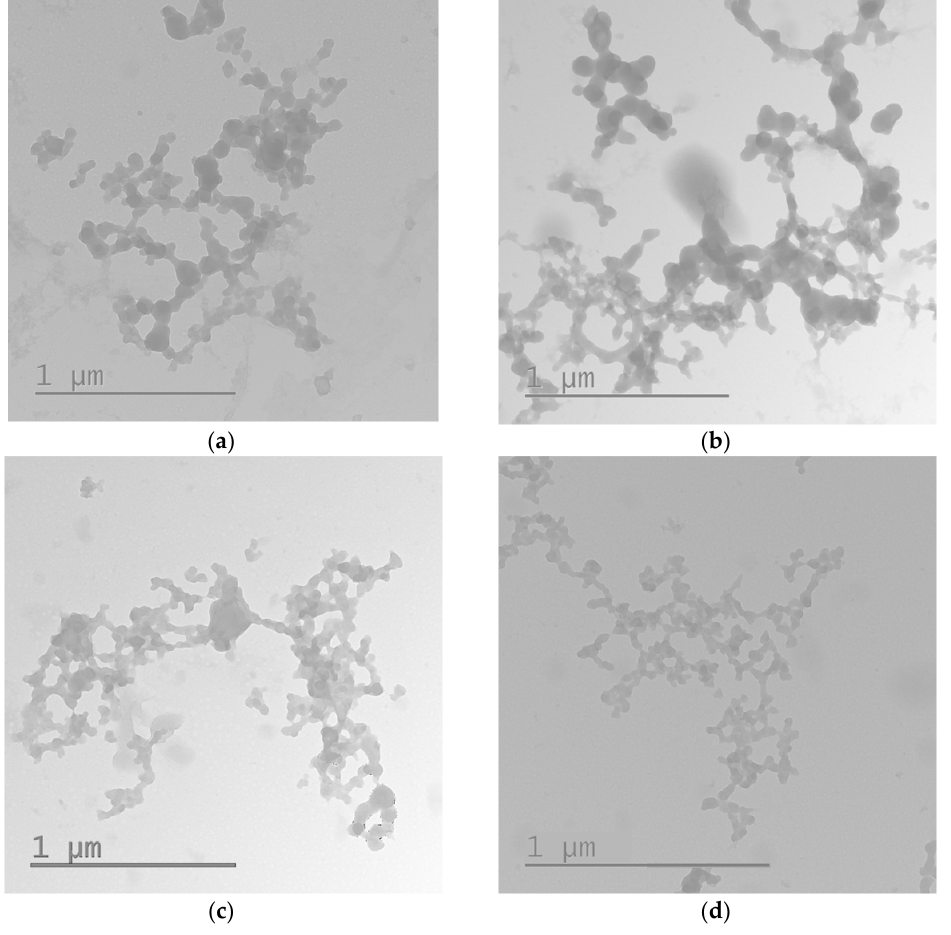
Figure 2. Typical micrographs of the RGD-R6p-0,75/DNA ( a , b ) and RGD0-R6p-0,75/DNA ( c , d ) polyplexes obtained by transmission electron microscopy: ( a , c ) N/P ratio 8/1; ( b , d ) N/P ratio 12/1. Previous studies on arginine-rich peptide/DNA polyplexes demonstrated that 6000 nm aggregates possess more efficient transfection in comparison with 400 nm polyplexes